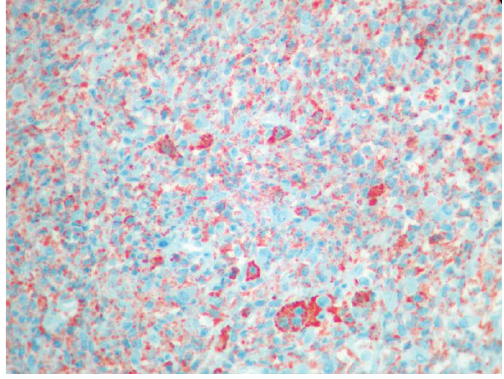
Figure 5: Immunohistochemistry × 40 CD68 positivity in mononu- clear, histiocytic, and multinuclear giant cells.